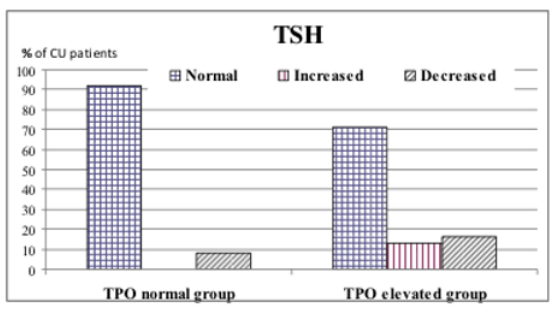
Figure 1. TSH results in different TPO groups of CU patients.